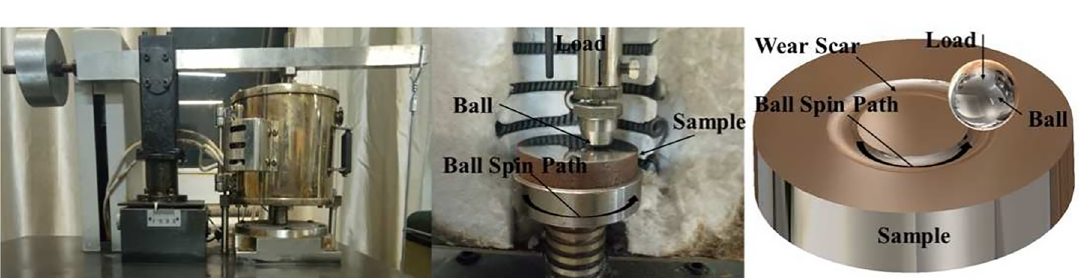
Figure 3. MGG-02 high temperature reciprocating friction and wear testing machine: (a) experimental setup and (b) working principle